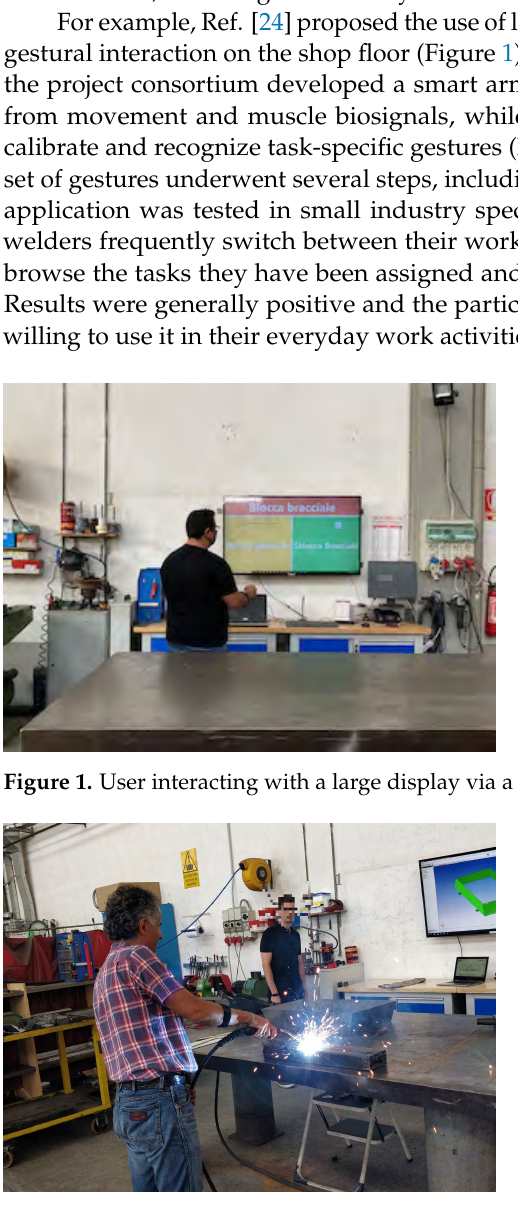
Figure 2. User testing a smart armband for gestural interaction on the shop floor